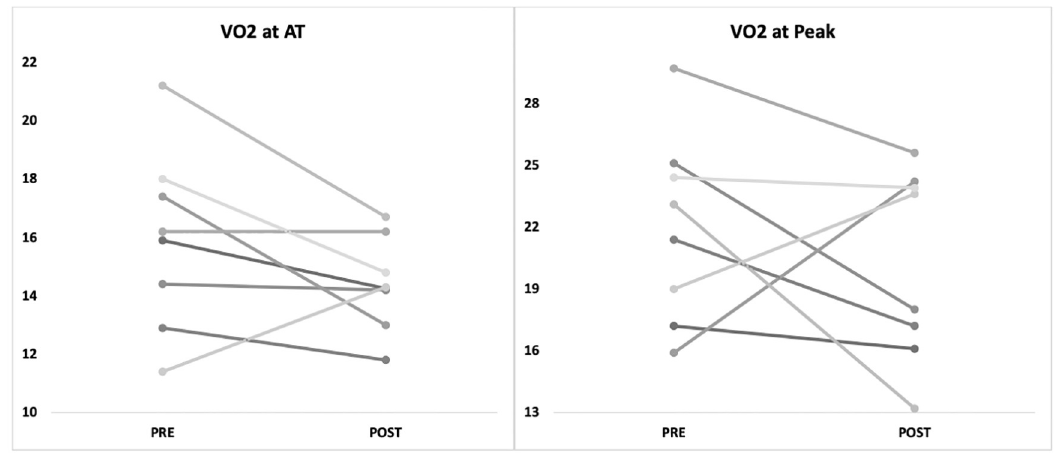
Fig 2. VO 2 at AT and peak (ml.kg -1 .min -1 ) pre- and post (at 12 weeks) CRS-HIPEC. Note: Lines link data-points (closed circles) for individual patients (n = 8).